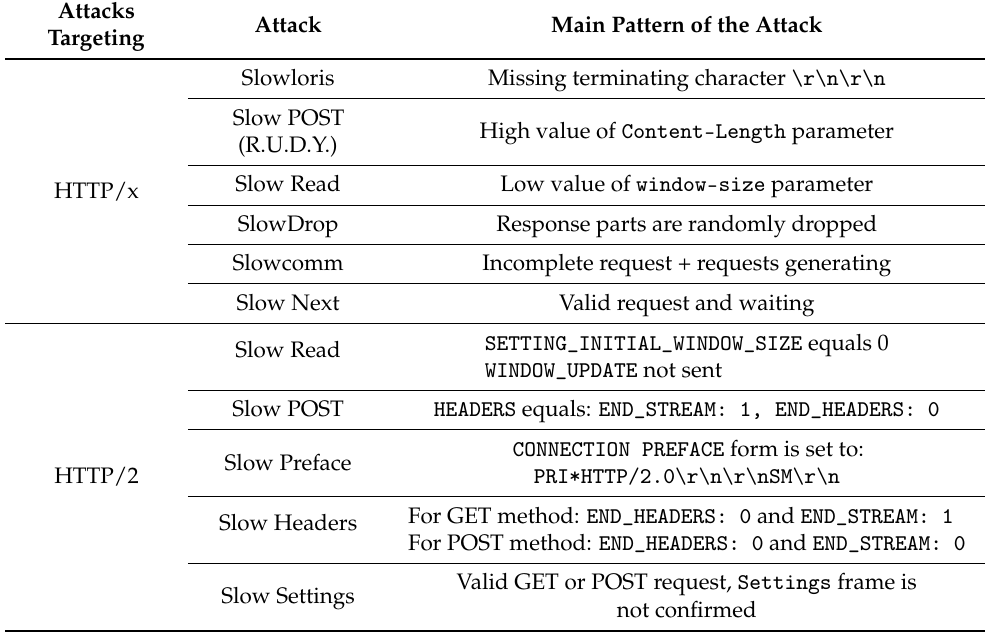
Table 2. Summary of selected slow DoS attacks and their main